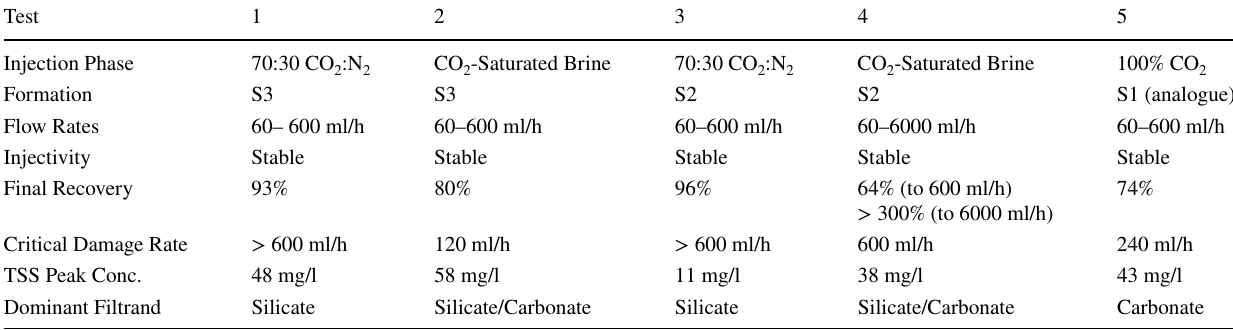
Table 15 Result comparison of fines mobilization core